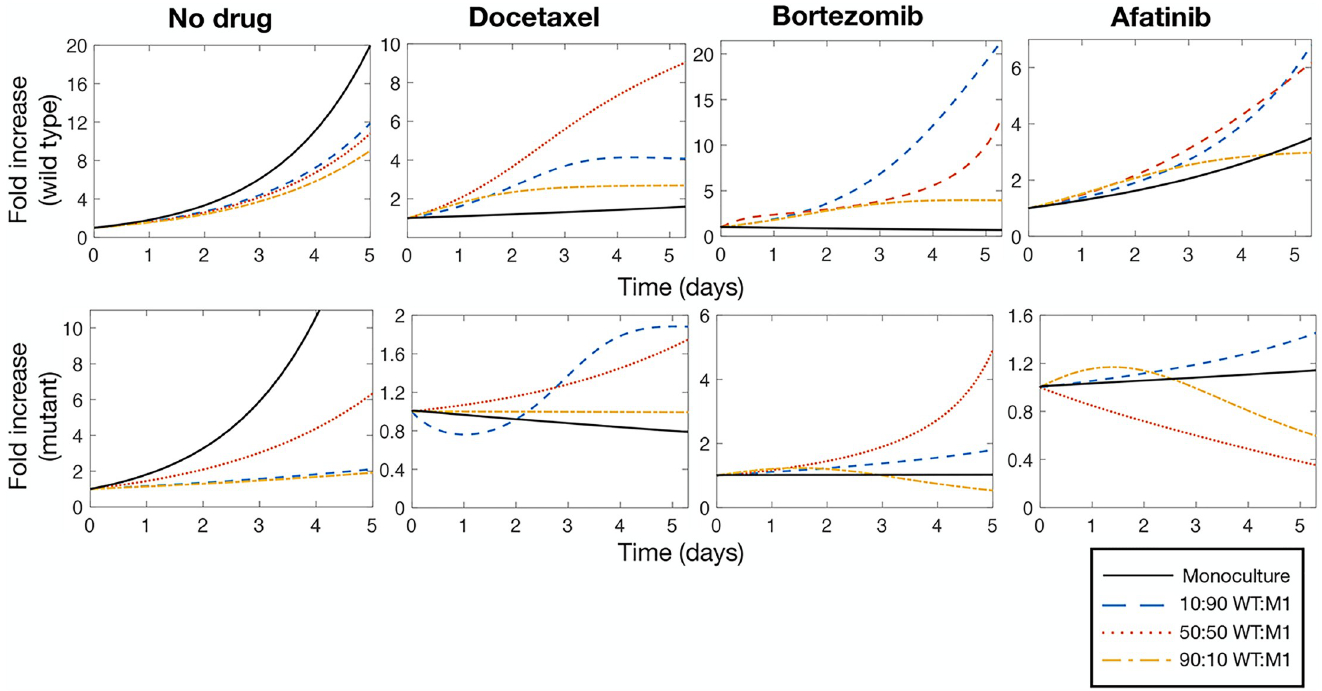
Fig 5. Heterogeneity is beneficial to growth during drug exposure. In absence of drug pressure, monoculture growth (solid black line) for both WT and M1 is significantly faster than all three co-cultures of 10:90 (dashed blue line), 50:50 (dotted red line), and 90:10 (dashed-dotted yellow line) mixes of WT:M1. However, when exposed to docetaxel, bortezomib, and afatanib, co-culture heterogeneity is beneficial to both cell types, conferring faster growth than in the monoculture case. Top: model predictions of WT growth; bottom: model predictions of M1 growth.